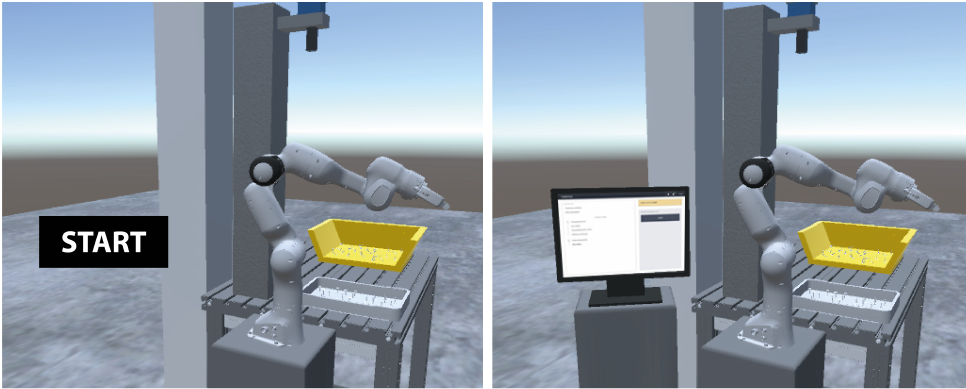
Figure 10. Low fidelity prototype (on the left ) and high fidelity prototype (on the right )